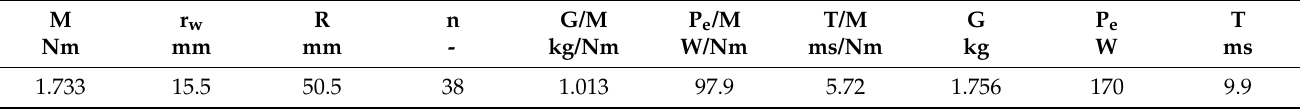
Table 6. Values of the ratios G/M, Pe/M, T/M and G, P e , T for the optimized PHB.